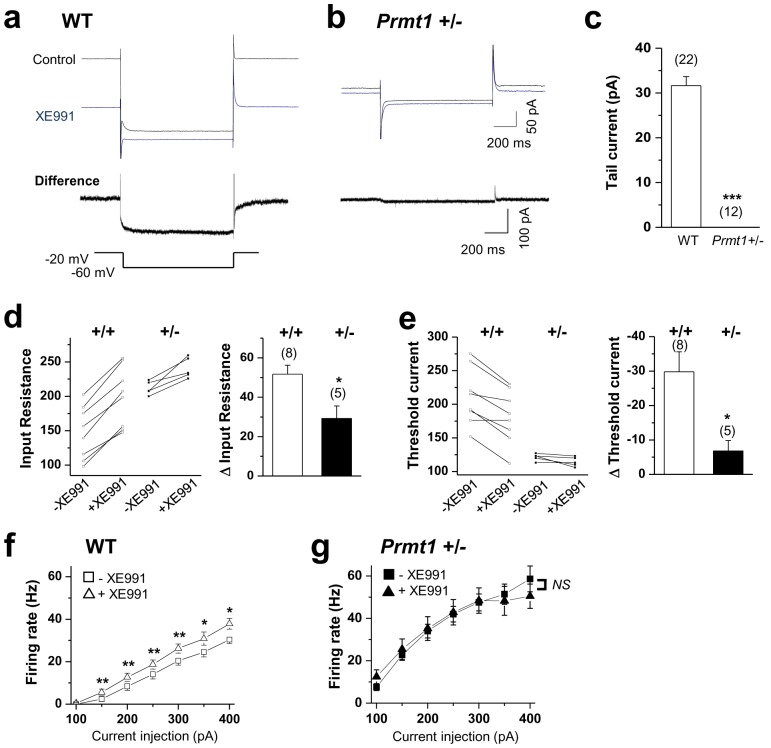
KCNQ current deficiency contributed to the persistent hyperexcitability in Prmt1+/- mice.(a–b) Representative current traces of voltage clamp recordings from WT (a; n = 22, seven mice) and Prmt1+/- (b; n = 12, four mice) mature dentate GCs in response to the voltage protocol depicted below. The upper panel shows the overlay of currents in the absence (black) or presence (blue) of 10 μM XE991. To illustrate the kinetic components of M-current relaxation and activation, the corresponding difference current is shown in an expanded scale below each current trace. (c) Summary statistics from experiments shown in a–b reveal loss of M-current in Prmt1+/- mice. Error bars, S.E.M. ***p<0.001 by Student’s t-test. (d–e) Changes in input resistance (d) and threshold current (e) in WT (+/+) and Prmt1+/- GCs (+/-) in response to 10 μM XE991. Each connected line represents an individual neuron. Right panel displays the summary of changes in input resistance or threshold current upon application of 10 μM XE991. XE991 was less effective in mutants than in WT. (f–g) Average numbers of APs generated during incremental 1-s depolarizing current steps before and after application of XE991 in WT (f) and Prmt1+/- GCs (g). XE991 produced a substantial change in firing rate of WT GCs (f; n = 7~11, seven mice), whereas little change in firing rate occurred with XE991 in Prmt1+/- GCs (g; n = 9, seven mice). *p<0.05; **p<0.01 by paired Student’s t-test.DOI:
http://dx.doi.org/10.7554/eLife.17159.00710.7554/eLife.17159.008Figure 3—source data 1.Source data for Figure 3.